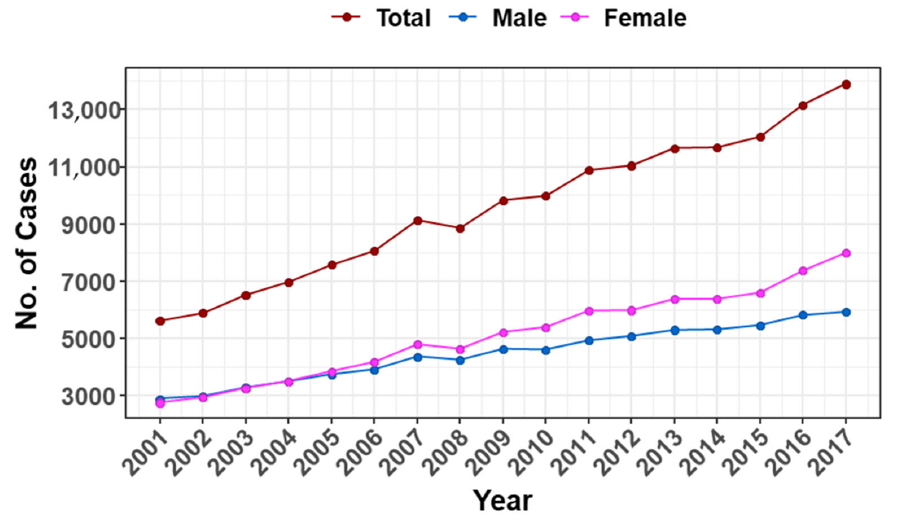
Figure 2. Distribution of cancer cases among the Saudi population by year. Shown are the number of all cancer cases ( y ‐ axis) for both genders (brown), males (blue), and females (pink) from 2001 to 2017, as indicated in the x ‐ axis.